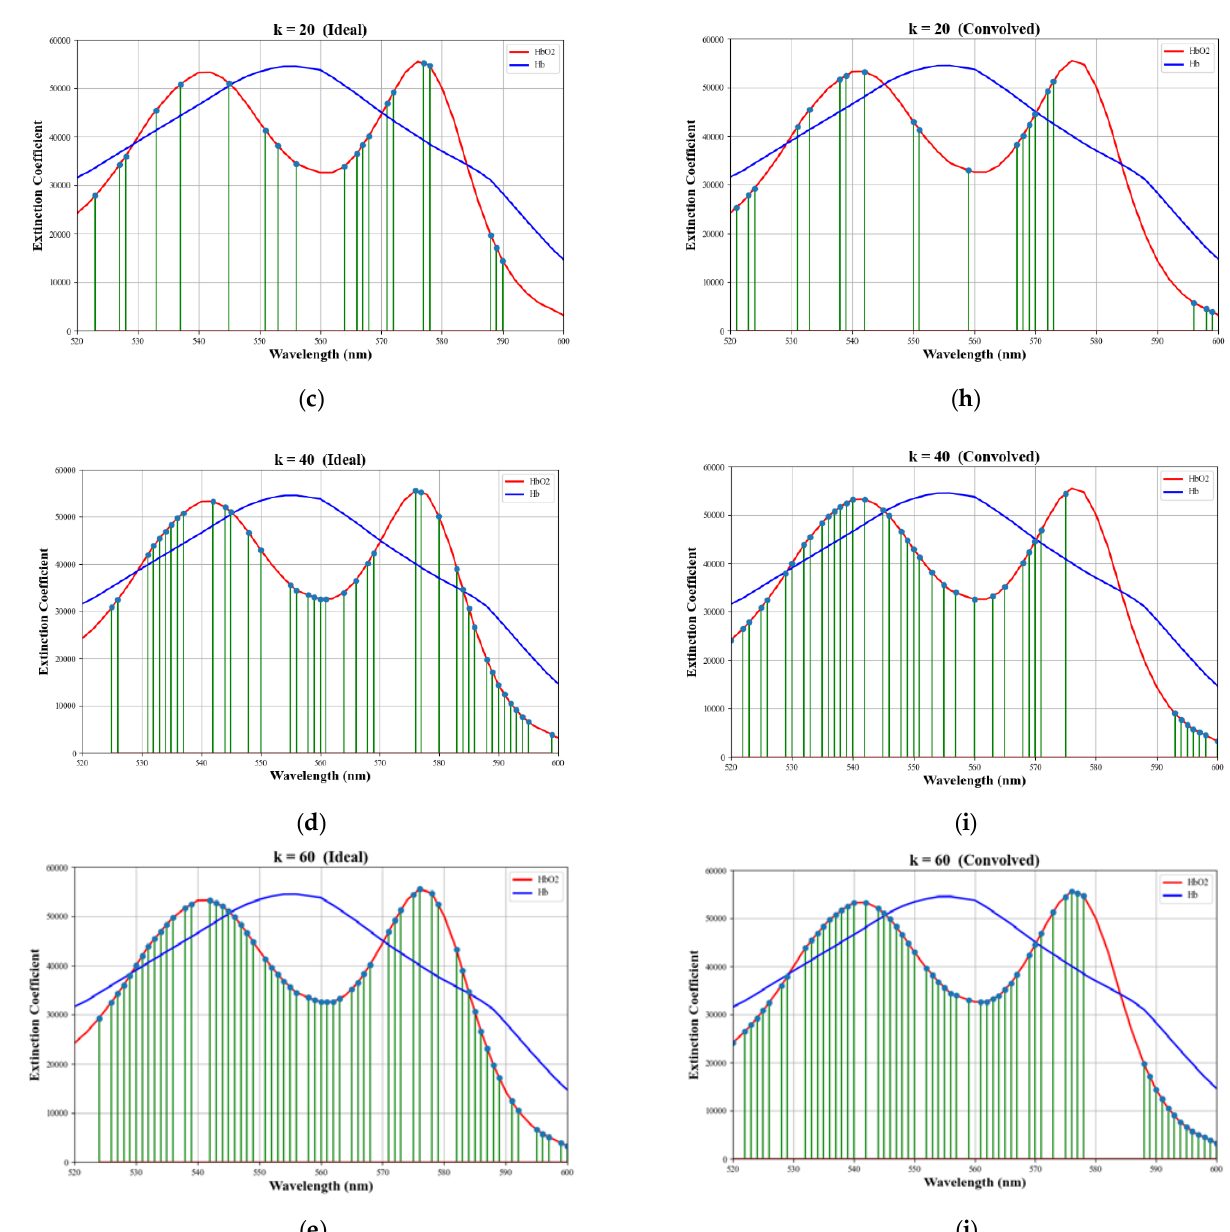
Figure 4. Wavelength selections for various values of k . The left column shows selections for the ideal case and the right column shows selections for the convolved case. ( a , f ) k = 5, ( b , g ) k = 11, ( c , h ) k = 20, ( d , i ) k = 40, ( e , j ) k = 60. The selections are superimposed on plots of the absorption coefficients for oxygenated (red) and deoxygenated (blue) hemoglobin.